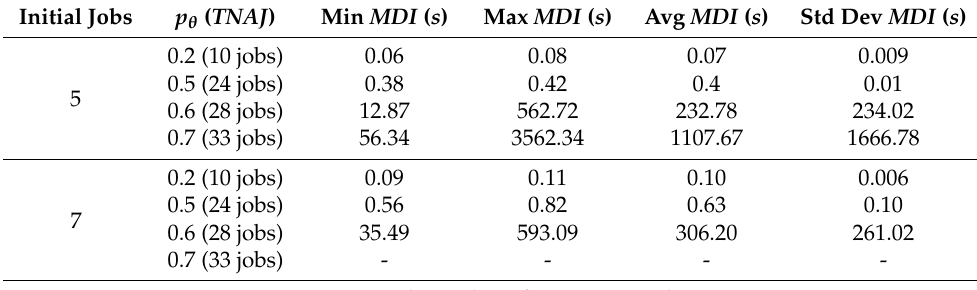
Figure 7. Variation of the objective for different solving methods. Table 13. Maximum duration of an iteration ( MDI